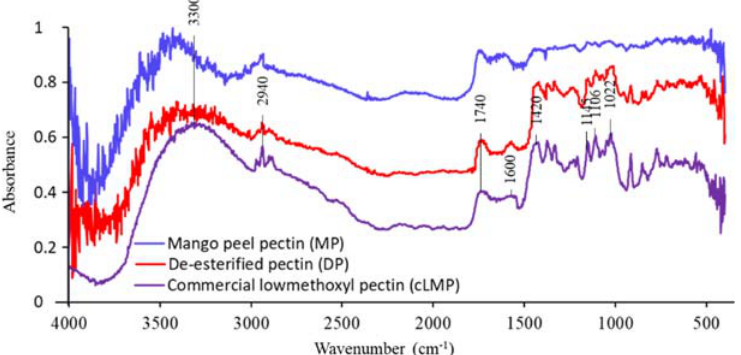
Figure 5. Fourier-transform infrared spectrophotometry (FTIR) spectra of mango peel pectin (MP), Figure 5. Fourier ‐ transform infrared spectrophotometry (FTIR) spectra of mango peel pectin (MP), de-esterified pectin (DP), and commercial low methoxyl pectin de ‐ esterified pectin (DP), and commercial low methoxyl pectin (cLMP).